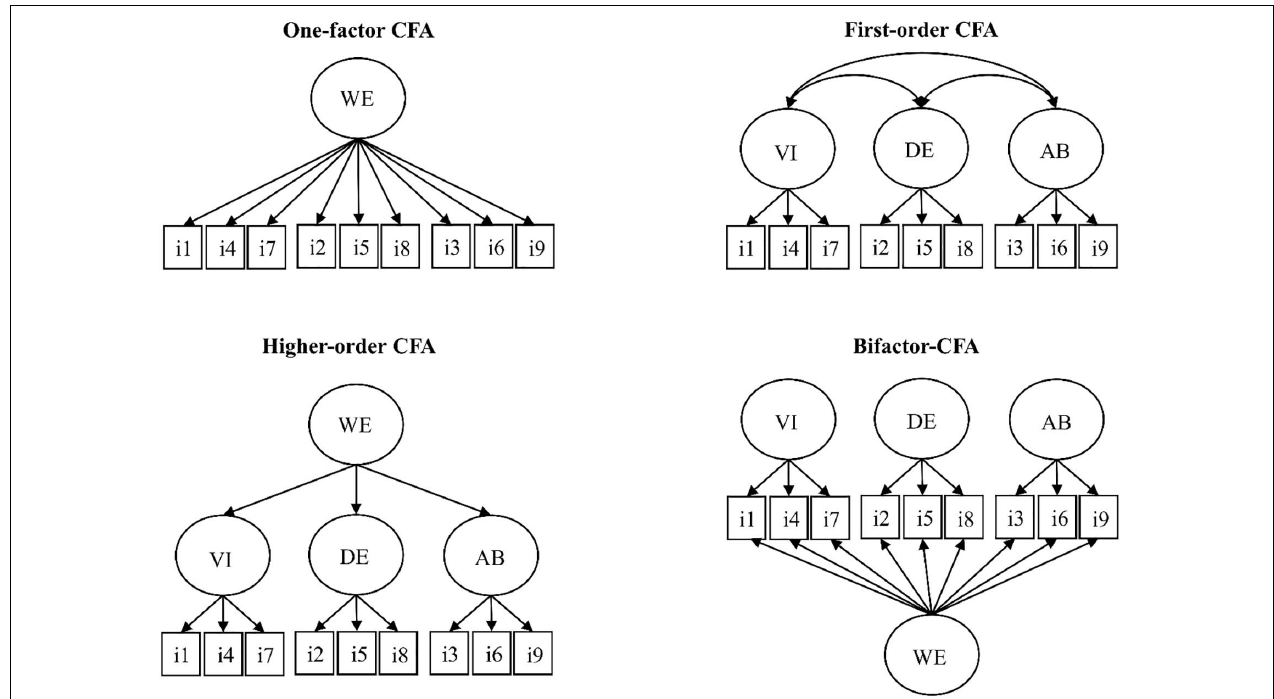
FIGURE 1 | Schematic representation of the estimated model for work engagement. Note. CFA, confirmatory factor analysis; i1-i9, item 1-9; VI, vigor; DE, dedication; AB, absorption; WE, work engagement. Unidirectional arrows represent factor loadings, bidirectional arrows represent